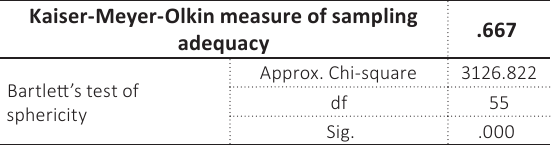
Table 8. KMO and Bartlett’s test